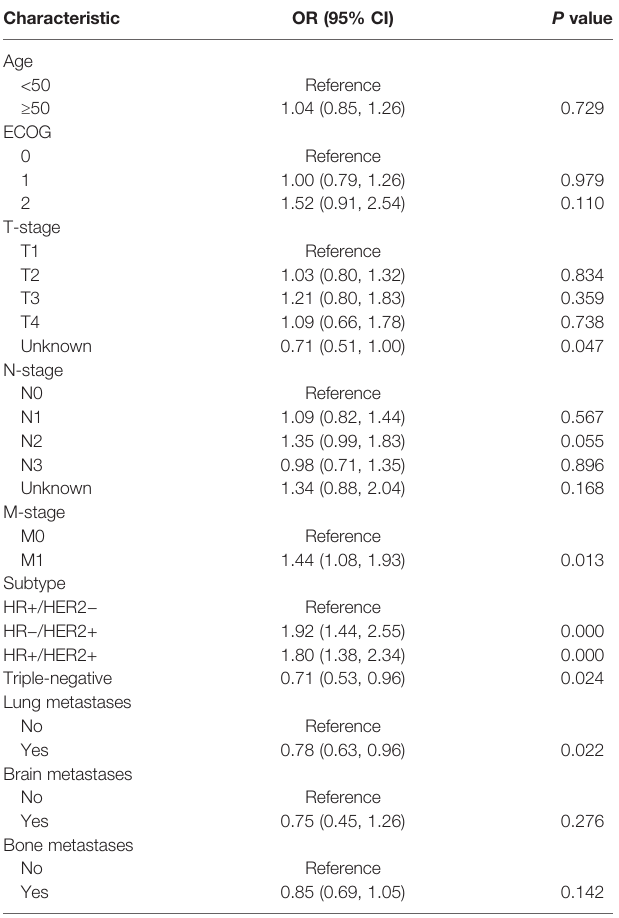
TABLE 3 | Multivariate logistic regression for the presence of liver metastases at initial metastatic breast cancer diagnosis. Characteristic